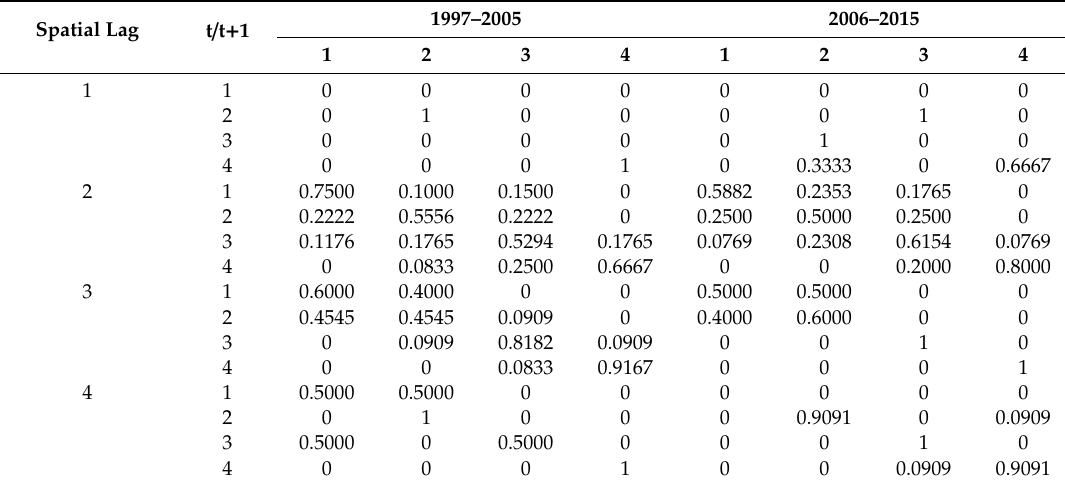
Figure 7. The change of Industrial Energy eco-e ffi ciency in the Yangtze River Economic Belt. Table 3. Markov Probability Transfer Matrix of Eco-efficiency of Industrial Energy in the Yangtze River Economic Belt from 1997 to 2015.